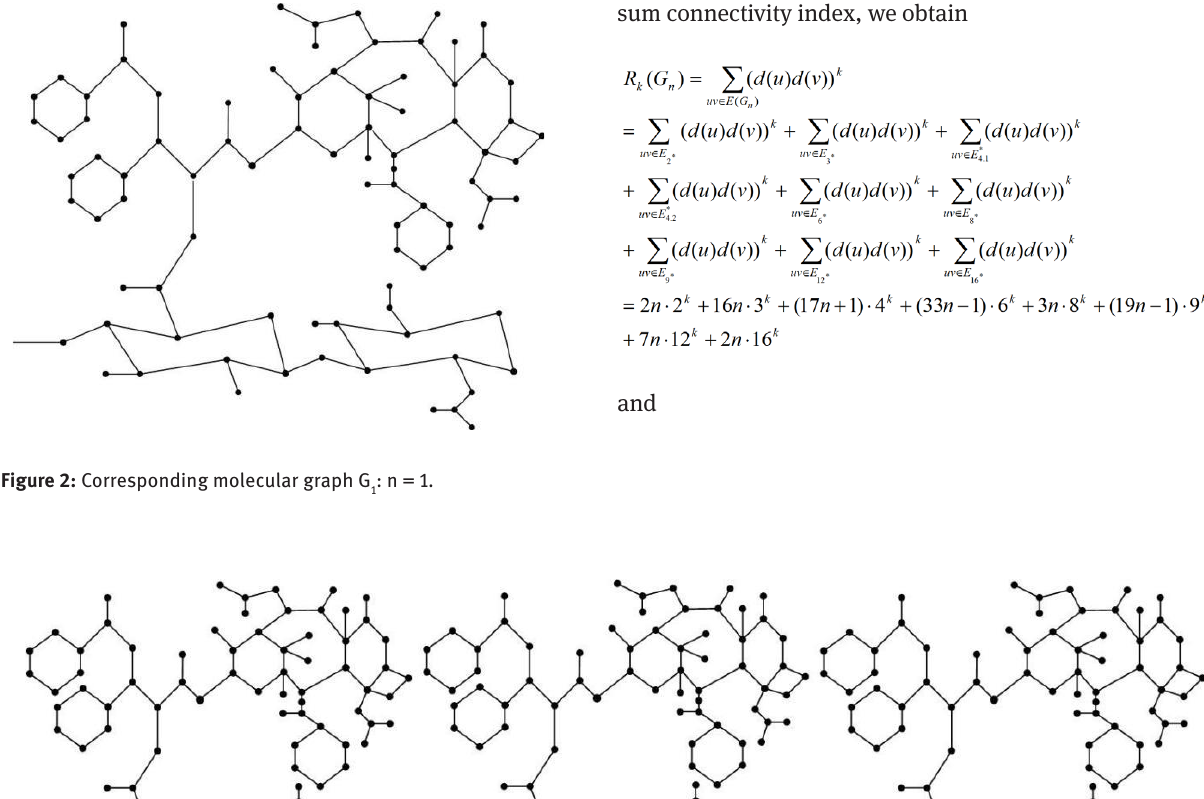
: n = 3. 3 : n = 3 Figure 3: Corresponding molecular graph G : n = 3. 3